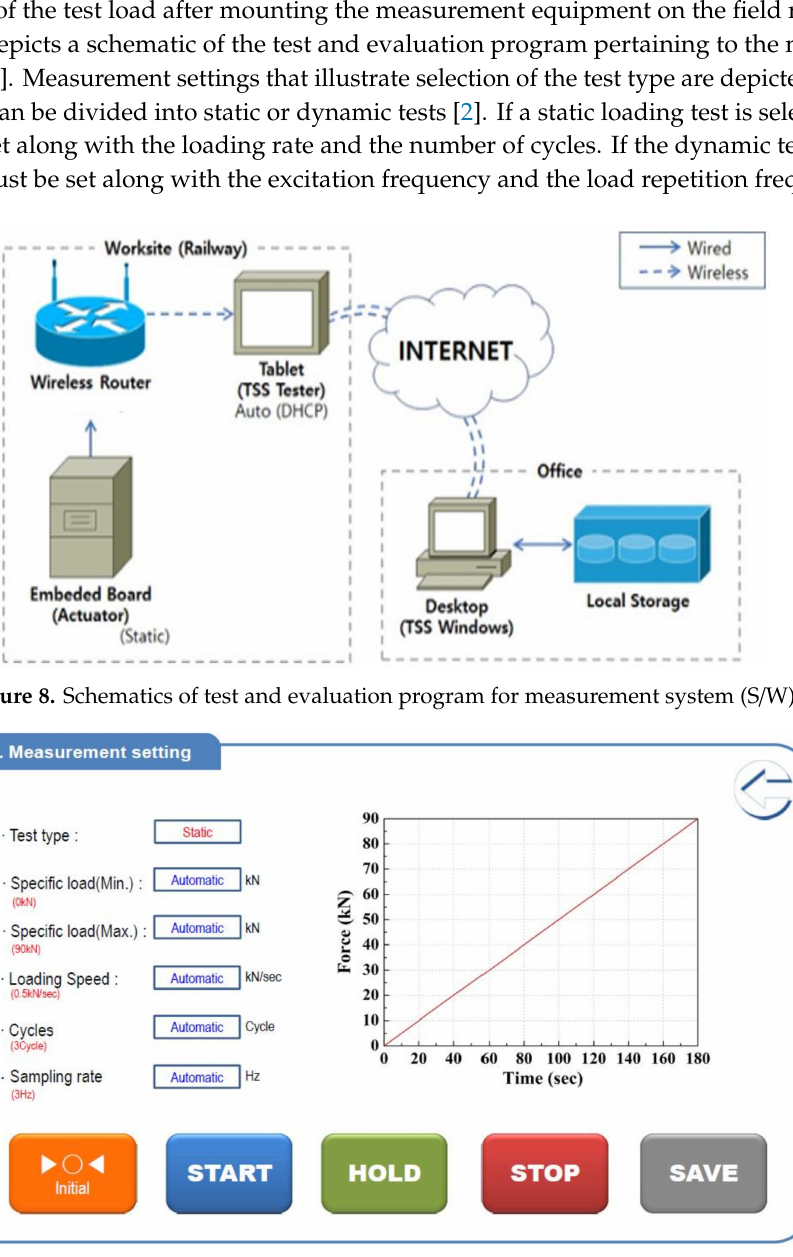
Figure 9. Setting of test